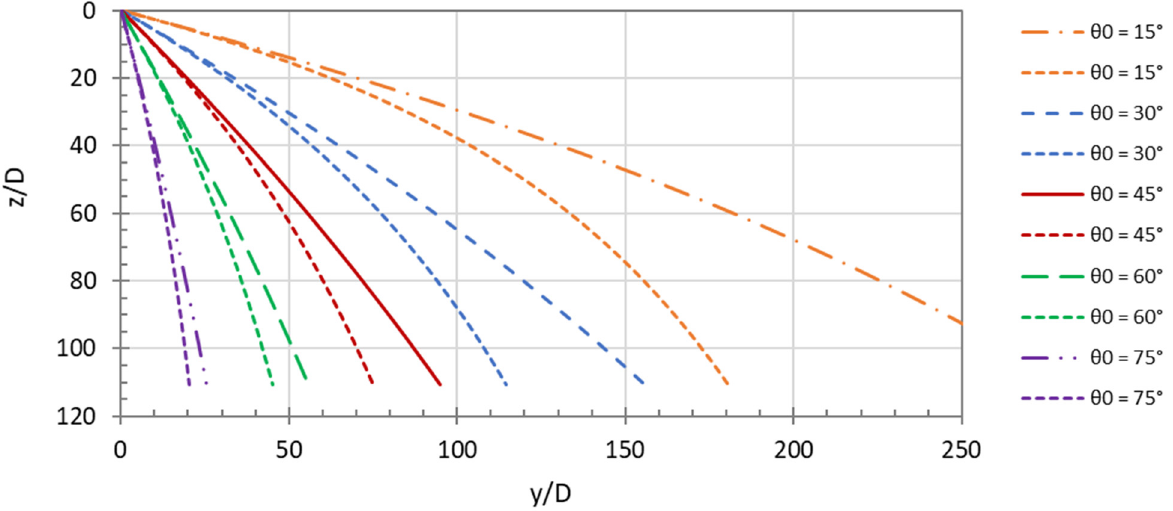
Figure 4. Dimensionless buoyant jet trajectories at the first cycle of air conditioning operation and at the last cycle for the inclination angles examined. The results for the last cycle are shown with the same colour as for the first cycle colour, but with lines of the smallest dash. Table 1. For each initial inclination angle examined, trajectory lengths l 1 and l 2 of the buoyant jet at the first and the last simulation cycle, along with the corresponding total times t 1 and t 2 , as well as the total duration t tot of all cycles, for temperature stabilisation of the room air at 27 ◦